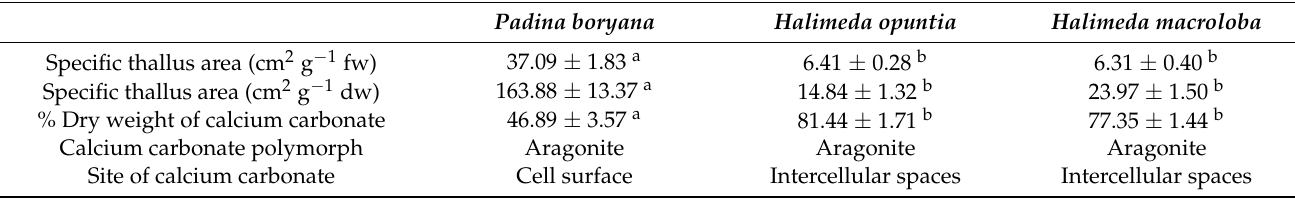
Figure 1. Aragonite crystal microstructure of Padina boryana ( A , B ), Halimeda opuntia ( D , E ) and Halimeda macroloba ( G , H ) from scanning electron microscope, cell of P. boryana ( C ), primary utricle (pU) and primary interutricle spaces (pIUS) of H. opuntia ( F ) and H. macroloba ( I ) from transmission electron microscope and compound microscope. Table 1. Morphological and anatomical characters of Padina boryana , Halimeda opuntia and Halimeda macroloba . Data are Mean ± SE. Different uppercase letters indicate statistical difference (Fisher’s LSD test, p <